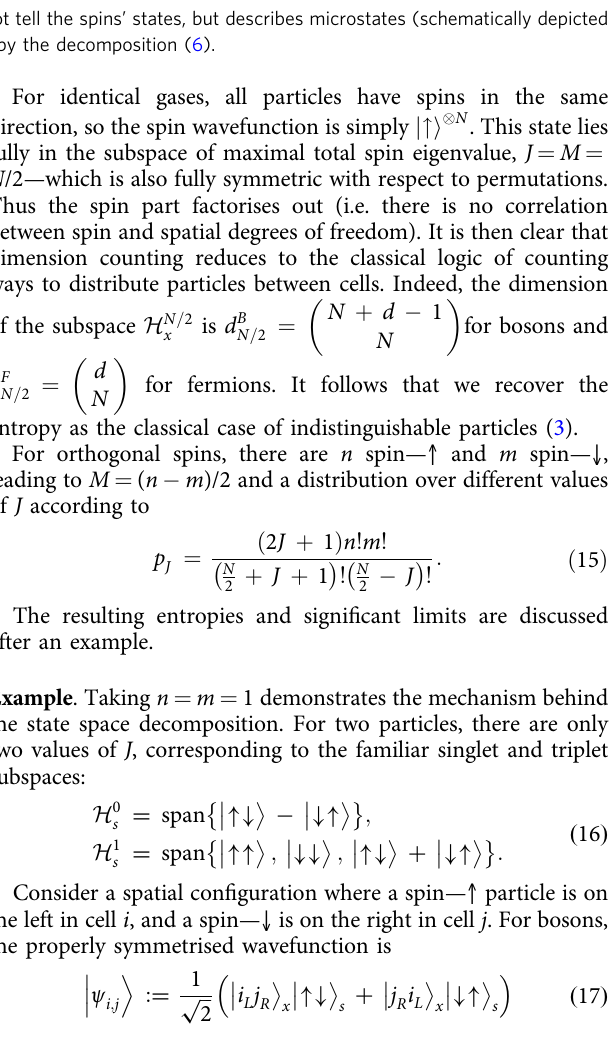
The probabilities p J are found (see Supplementary Note 2) from the Clebsch-Gordan coef fi cients C ( j 1 , m 1 ; j 2 , m 2 ; J , M ) describing the coupling of two spins with angular momentum quantum numbers ( j 1 , m 1 ), ( j 2 , m 2 ) into overall quantum numbers ( J , M ). Here, the two spins are the groups of particles on the left and right, respectively.